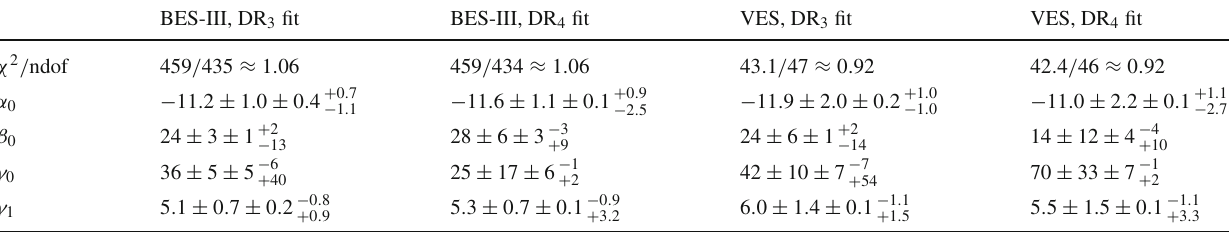
Table 3 Fit results for the DR 4 subtraction constants for the BES-III and VES data samples, obtained from the three-parameter fits via the sum rule (26) and directly from the four-parameter fits. The first error is